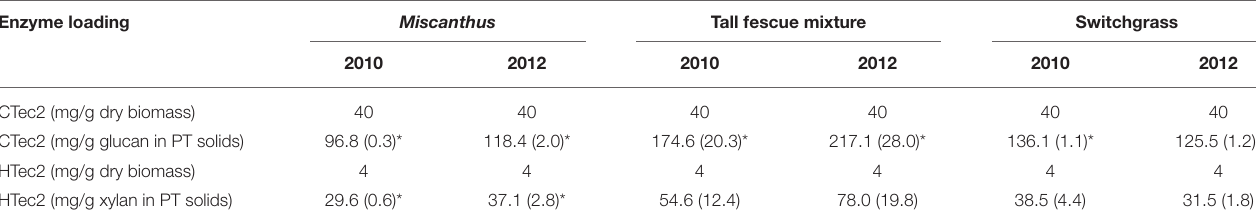
TABLE 5 | Enzyme loadings for hydrolysis on a per gram dry biomass basis and per grams of sugar in the pretreated (PT) solids for Miscanthus , the tall fescue mixture, and switchgrass grown in 2010 and 2012 [ n = 3; mean (1 SD )]. Enzyme